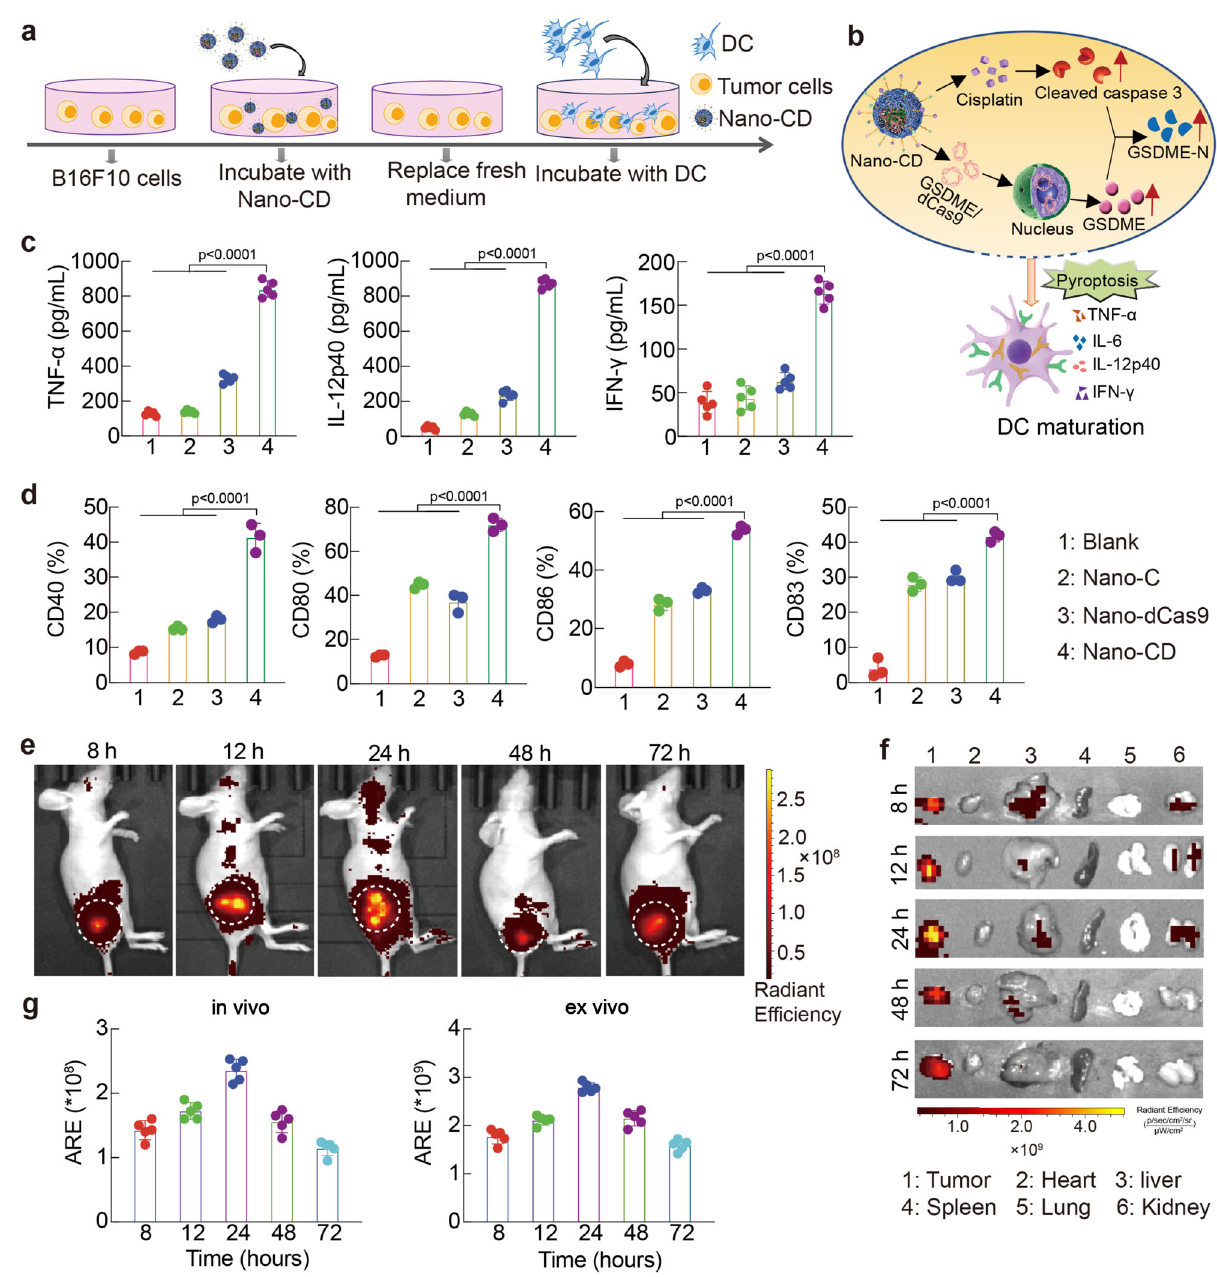
Fig. 4 | Immune stimulation of DC by Nano-CD in vitro. a Illustration of the experimental procedure in vitro. b The mechanism illustration of DC maturation. c , ELISA assay for TNF- α , IL-12p40 and IFN- γ proin fl ammatory cytokines ( n =4 biologicalreplicatespergroup). d Pro fi leofDCmaturationbyFCM( n